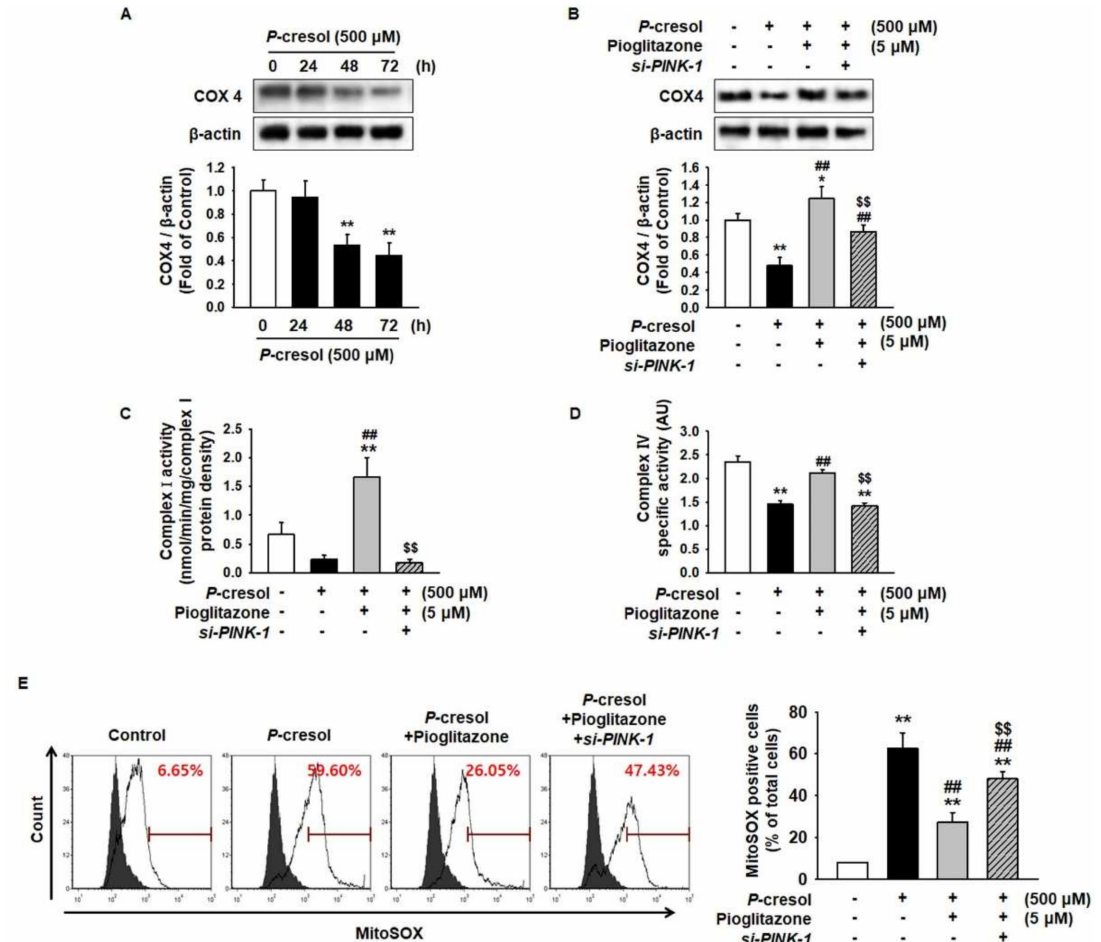
Figure 5. Pioglitazone-treated MSCs restored mitochondrial function by increasing